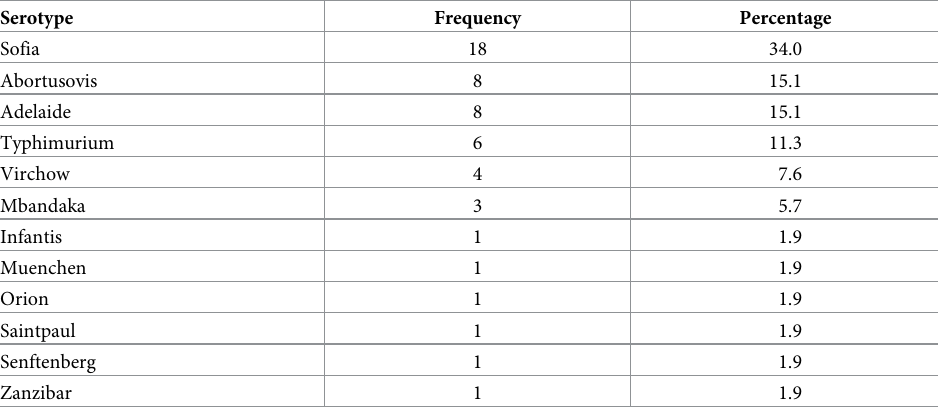
Table 1. Distribution of Salmonella serotypes isolated from Australian meat chickens.